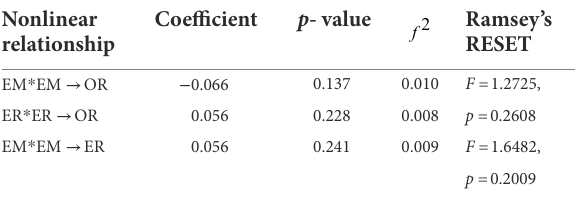
TABLE 9 Assessment of nonlinear effects.